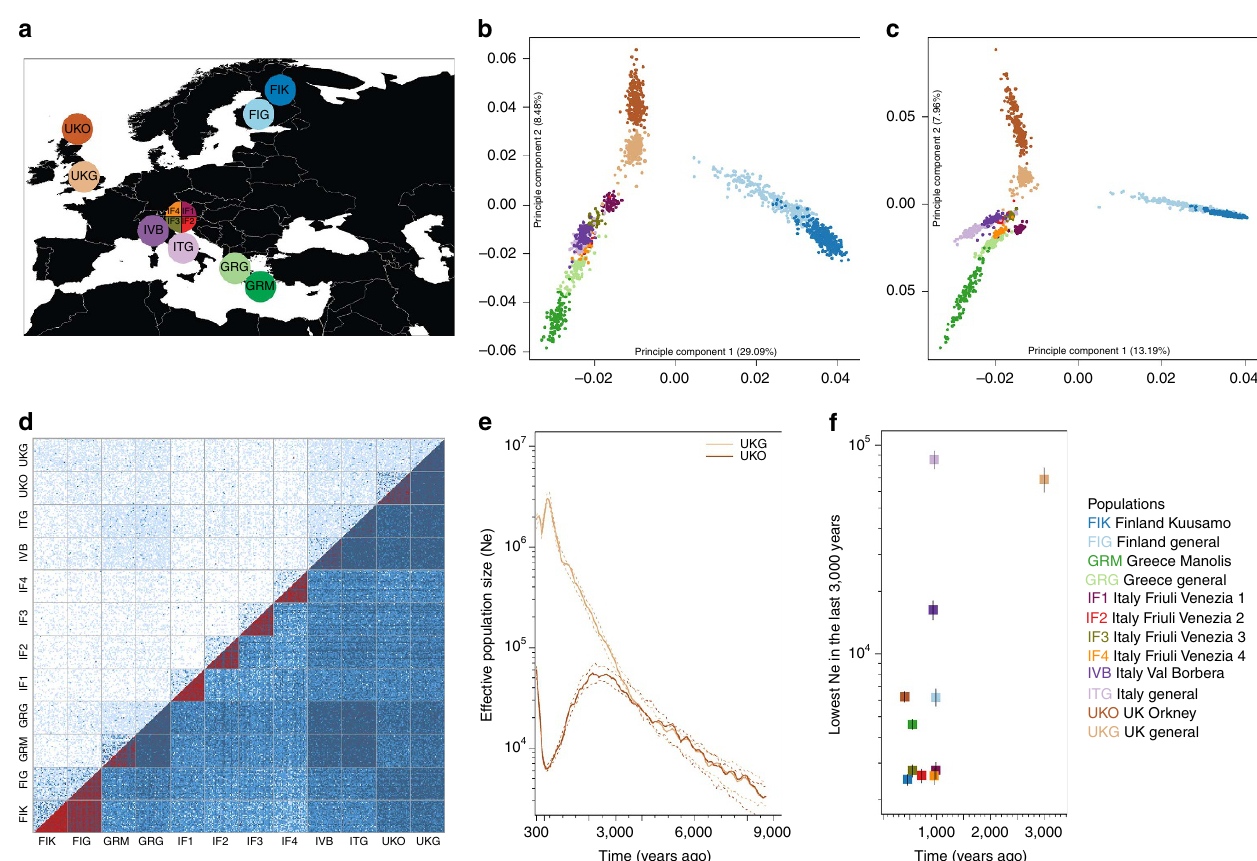
Figure 1 | General characteristics and demographic history of isolated and matched general populations. ( a ) Geographical locations of samples. The base map was plotted in R using the mapdata package and circles were added using Photoshop. ( b ) PCA using common variants. ( c ) PCA using low-frequency variants. ( d ) Sharing of rare variants within and between populations. Upper left triangle: f 2 variants; lower right triangle f 3 – f 10 variants. ( e ) Effective population size (Ne) inferred from IBDNe for UKO and UKG during the past nine KY. ( f ) The lowest Ne inferred by IBDNe for all populations for the past three KY, plotted as a function of the time at which it